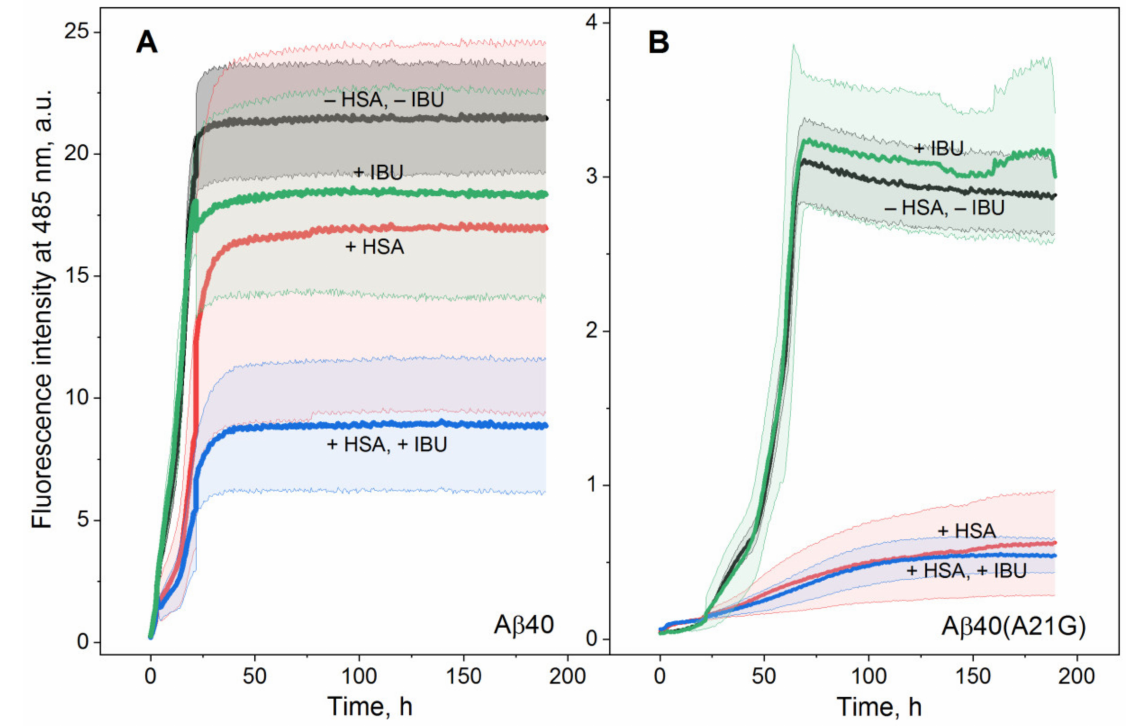
Figure 3. Kinetics of 20 µ M A β 40 ( A )/A β 40 (A21G) ( B ) fibrillation at 30 ◦ C depending on the presence of 2 µ M HSA and 20 µ M IBU, monitored using ThT fluorescence assay (25 mM Tris-HCl, 140 mM NaCl, 4.9 mM KCl, 1 mM MgCl 2 , 2.5 mM CaCl 2 , pH 7.4 with 0.05% NaN 3 ). The standard deviations of the fluorescence signals are indicated. Excitation at 440 nm; emission at 485